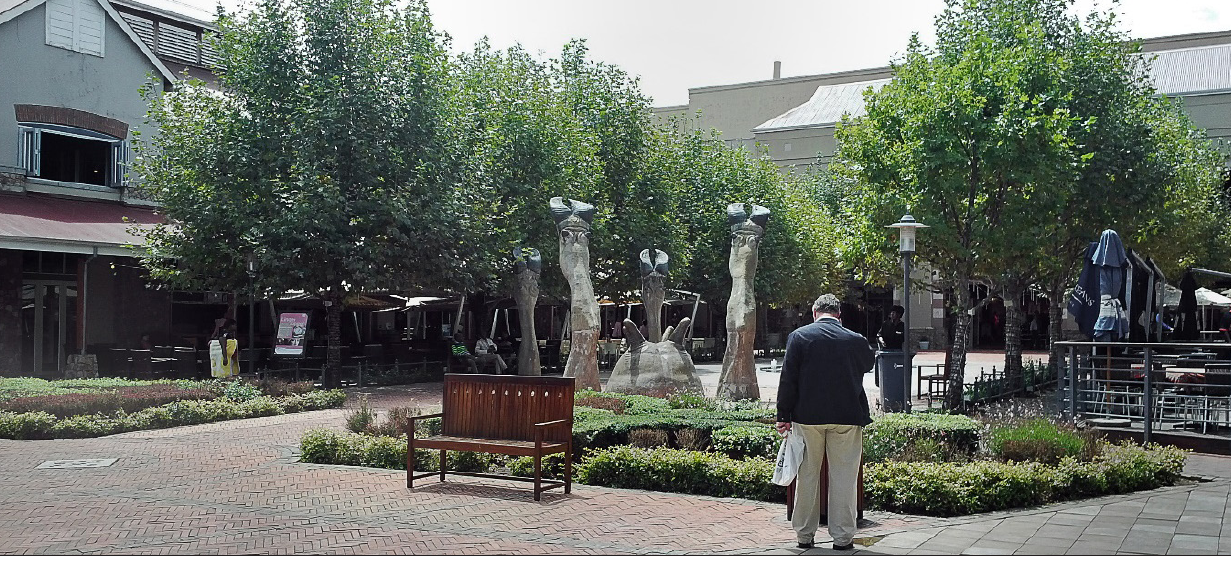
Figure 11: Looking from the other side of the Irene Village Mall plaza towards the tree-lined space with restaurants on both sides and a large sculpture in the